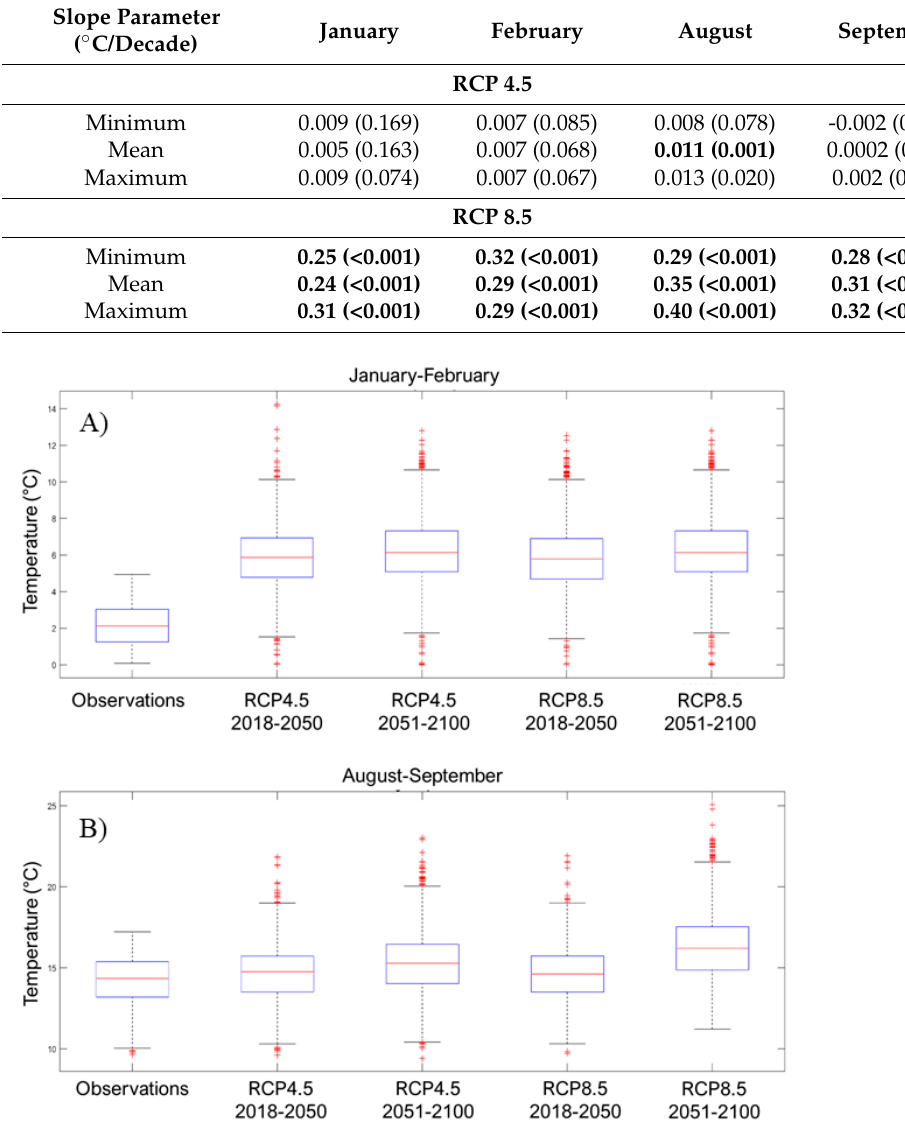
Figure 8. Box plots of water temperatures in low flow conditions for the months of ( A ) January– February and ( B ) August–September, for the two climate change scenarios and to future periods. For each box plot, the red line indicates the median, the bottom and top edges of the box indicate the 25th and 75th percentiles, respectively, the whiskers indicate the most extreme data points not considered outliers, and the outliers are indicated with the ‘+’ red symbol.